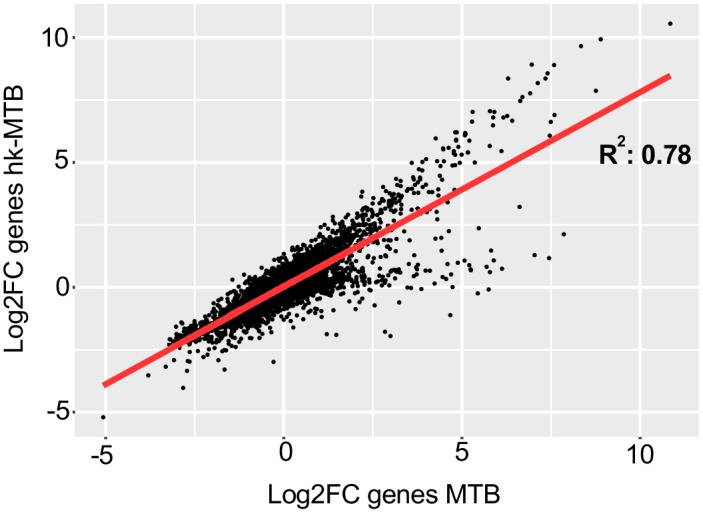
Scatterplot depicting the correlation between the log2 fold changes (log2FC) in gene expression levels using live MTB and heat-killed bacteria.